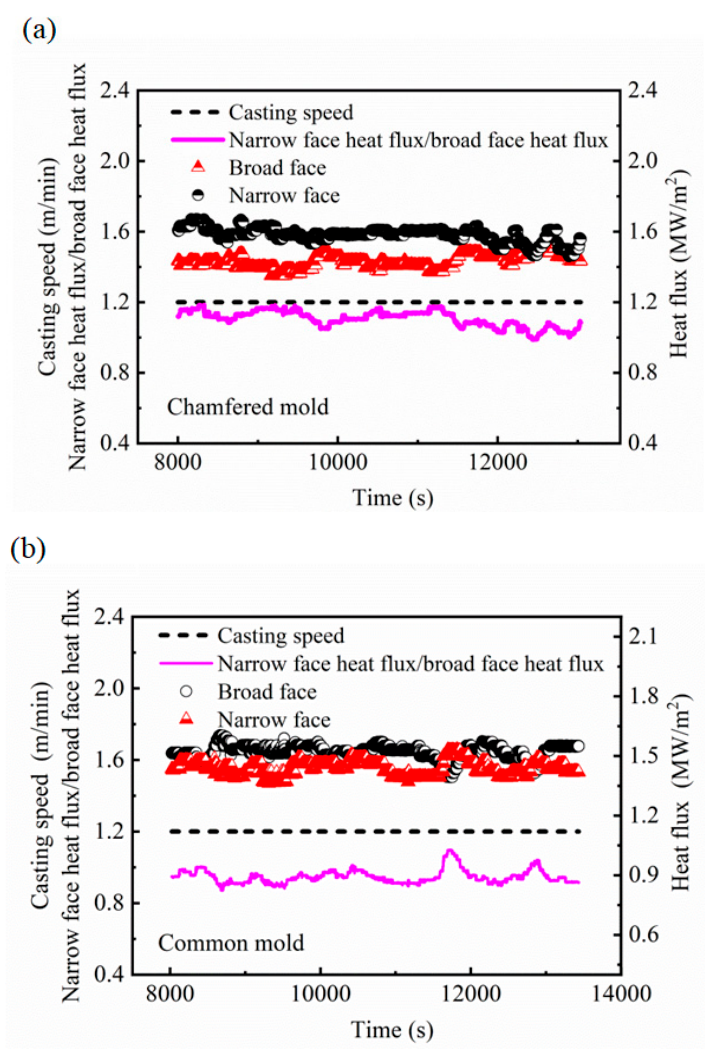
Figure 13. Heat flux values in different molds. ( a ) Chamfered mold; ( b ) Common mold.